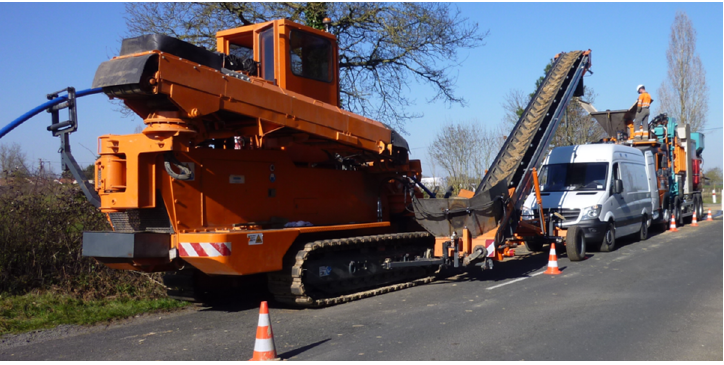
Figure 11. The Mec-H mobile production unit on Yzernay site. YZE-N-01 and YZE-N-02 were mixed together and termed YZE-N. All upcoming testing was performed on YZE-N. The UCS, tensile strength, and CBR results for Yzernay TC after mixing with all three types of binders are presented in Figure 12.